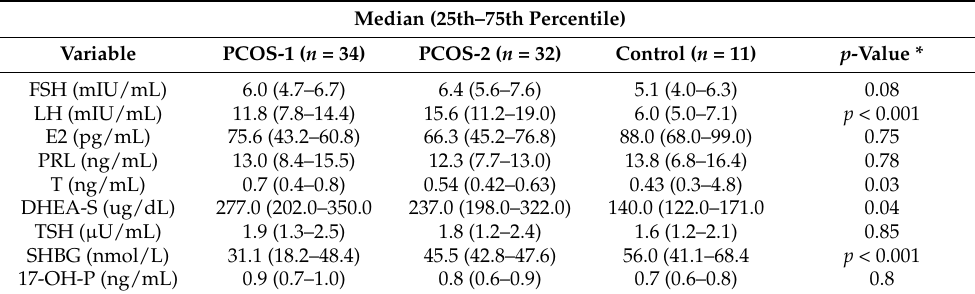
Table 3. Hormonal analysis: PCOS-1 vs. PCOS-2 vs.